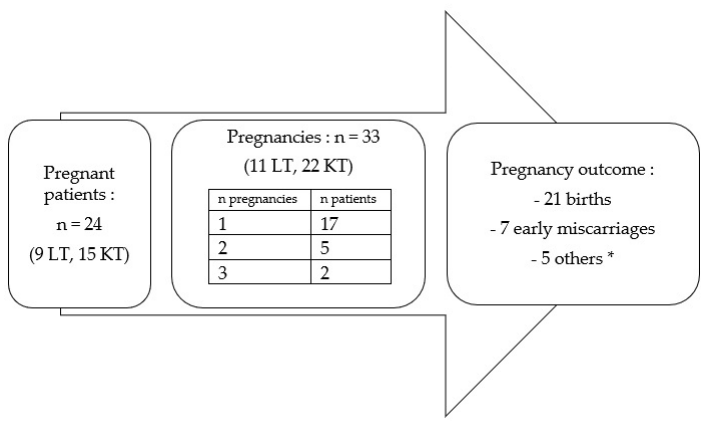
Figure 2. Characteristics of pregnancies in women after SOT. * 1 late loss, 1 medical termination, 1 1 ectopic pregnancy, 1 mole and 1 ectopic pregnancy, 1 mole and 1 abortion.